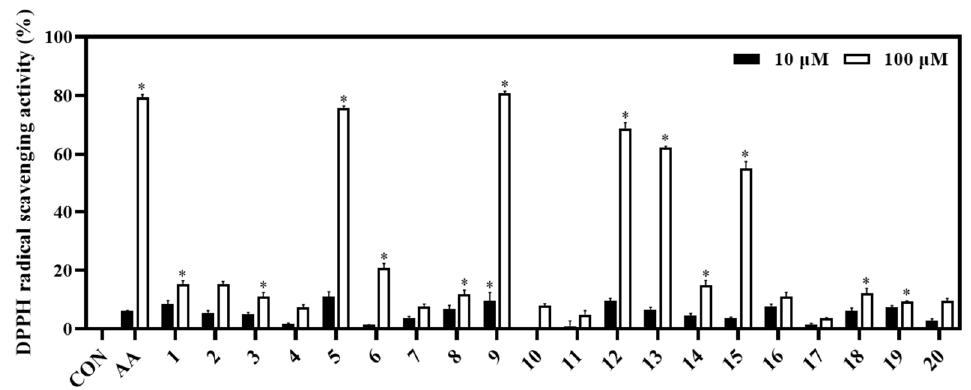
Figure 4. Antioxidant effect of compounds ( 1 − 20 ). The DPPH assay was performed in triplicate. The data are represented as mean ± SD. * p < 0.05, compared to control (CON). In the NO assay, compounds 9 and 12 − 14 exhibited strong inhibition against NO production in LPS-stimulated RAW264.7 cells, with inhibitory rates of 99.71%, 98.84%, 94.46%, and 84.55%, respectively, at 100 µ M. Compounds 10 and 15 showed significant inhibition (43.30% and 40.51%, respectively) under the same test conditions. In contrast, the active compounds 9 , 10 , and 12 − 15 did not exhibit significant cytotoxicity, which was verified by the MTT assay (Figure 5). Compound 20 displayed a strong inhibition against NO production with rate of 95.62% at the tested concentration of 100 µ M. However, compound 20 exhibited a cytotoxic effect on RAW264.7 cells based on the MTT assay. After treatment with the other compounds, the NO production was weakly reduced in LPS-stimulated cells, which did not show any proliferation (Figure 5).